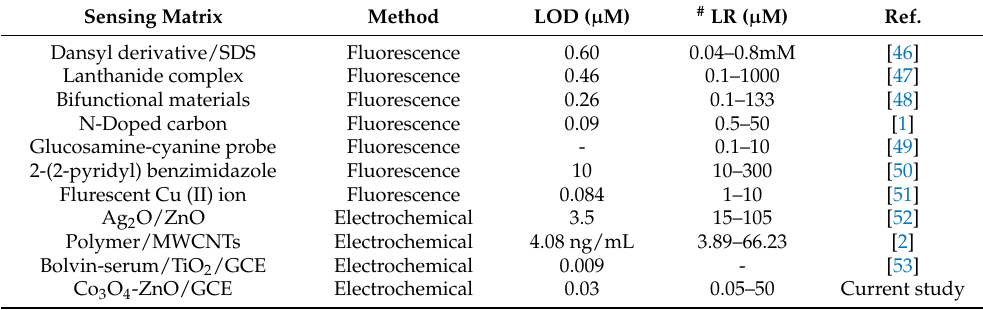
Table 2. Earlier-reported methods for the detection of aspartic acid and their analytical